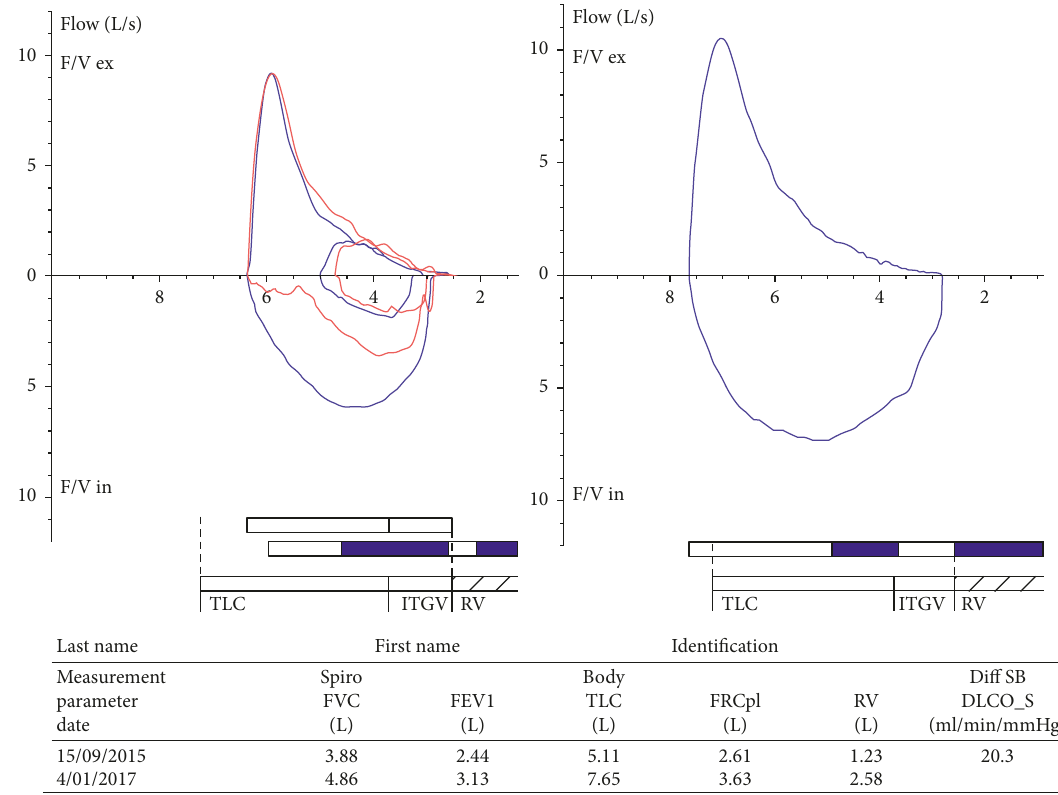
Figure 6: Comparison of preoperative and postoperative spirometry results showing marked improvement in respiratory